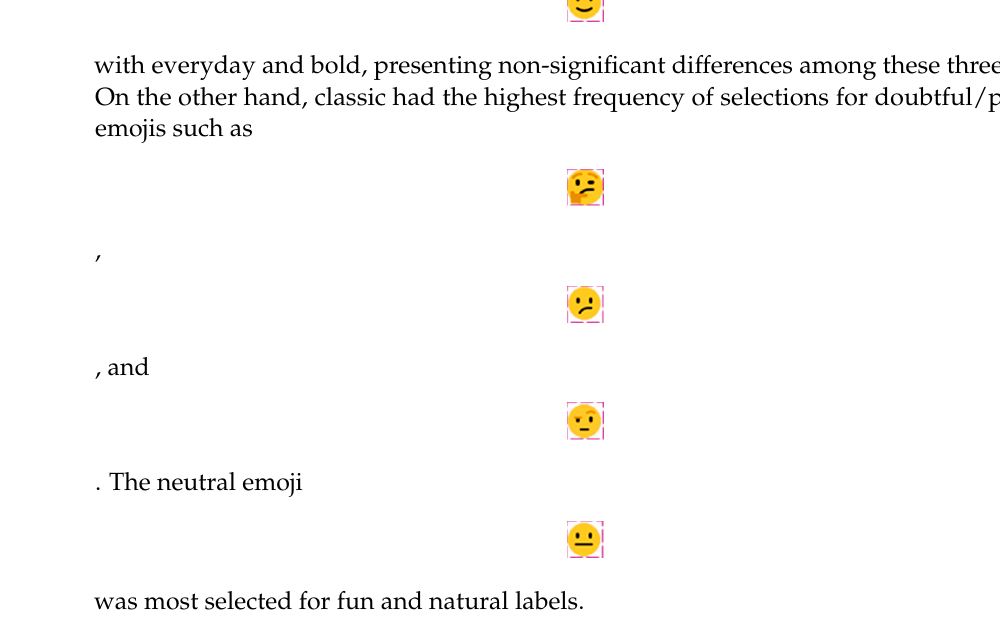
Table 2. Options provided for the check all that apply (CATA) questions for assessment of the coffee pod label samples.